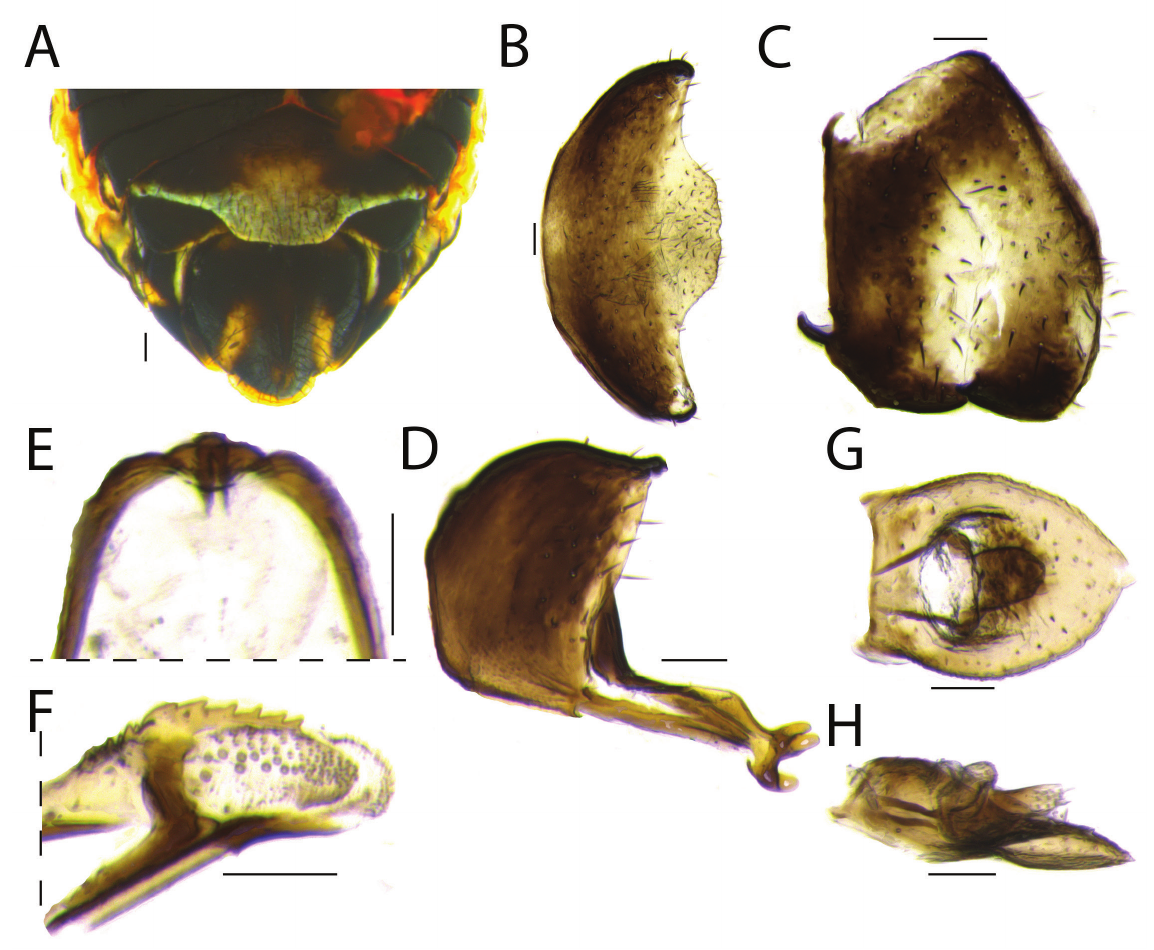
Fig. 17. Female terminalia of Nenema virgata (Doering, 1941) (INHS). A . External female terminalia, ventral view. B . Sternite VII, ventral view. C . Gonoplac, lateral view. D . Anterior connective lamina of gonapophysis VIII, ventral view. E–F . Posterior connective lamina of gonapophysis IX. E .